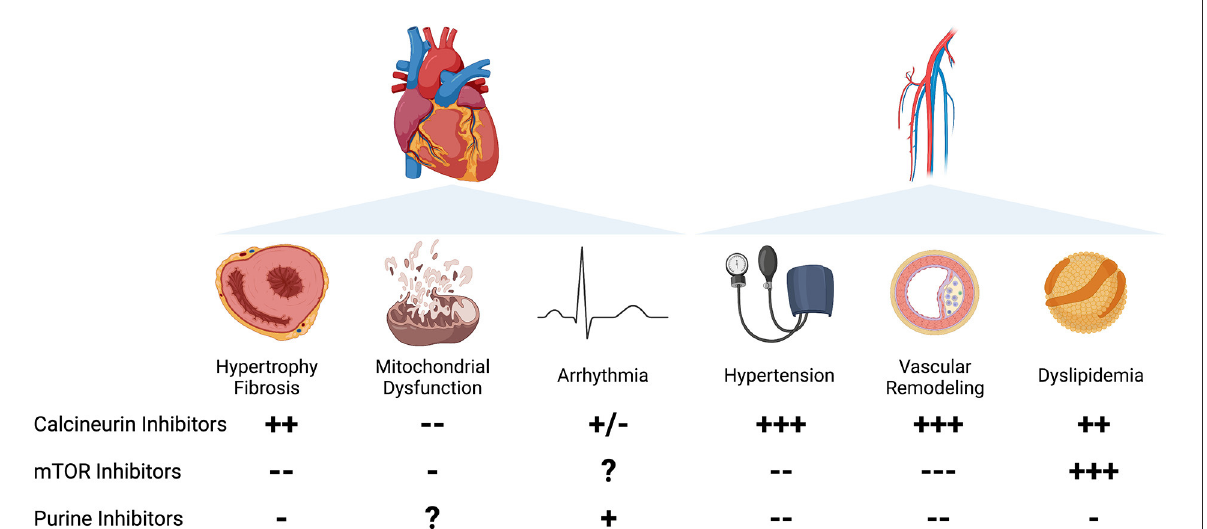
FIGURE1 Left Panel: Cardiac effects of immunosuppression. Column A: Calcineurin inhibitors are associated with increased hypertrophy in clinical studies, with mixed preclinical evidence. mTOR inhibitors are associated with a decrease in cardiac hypertrophy in patients and animal studies. Purine synthesis inhibitors prevent cardiac remodeling in limited evidence in preclinical studies. Column B: Calcineurin inhibitors, particularly CsA, prevent mitochondrial dysfunction and mPTP opening. mTOR inhibitors may prevent mitochondrial dysfunction in preclinical studies. The effects of purine synthesis inhibitors on mitochondrial function in the heart are unknown. Column C: Calcineurin inhibitors are associated with arrhythmia in limited clinical case reports, with mixed effects in animal studies. The effects of mTOR inhibitors on arrhythmia are unknown. Purine synthesis inhibitors, particularly azathioprine, are weakly associated with increased atrial arrhythmias in clinical case reports. Right Panel: Vascular effects of immunosuppression. Column A: Hypertension. Calcineurin inhibitors are strongly associated with an increased incidence of hypertension in preclinical and clinical studies. mTOR inhibitors and purine synthesis inhibitors have a vasodilatory effect in animal models and limited clinical studies. Column B: Vascular remodeling. Calcineurin inhibitors are strongly associated with proliferative vasculopathy and vascular inflammation. mTOR inhibitors protect against vascular damage in clinical studies and preclinical models. Purine synthesis inhibitors are associated with improvement in vascular remodeling in preclinical studies and limited clinical reports. Column C: Dyslipidemia. Calcineurin inhibitors are associated with increased total serum cholesterol and LDL. mTOR inhibitors, particularly sirolimus, are strongly associated with an increase in serum cholesterol and triglycerides. Purine synthesis inhibitors are weakly associated with improvement in serum